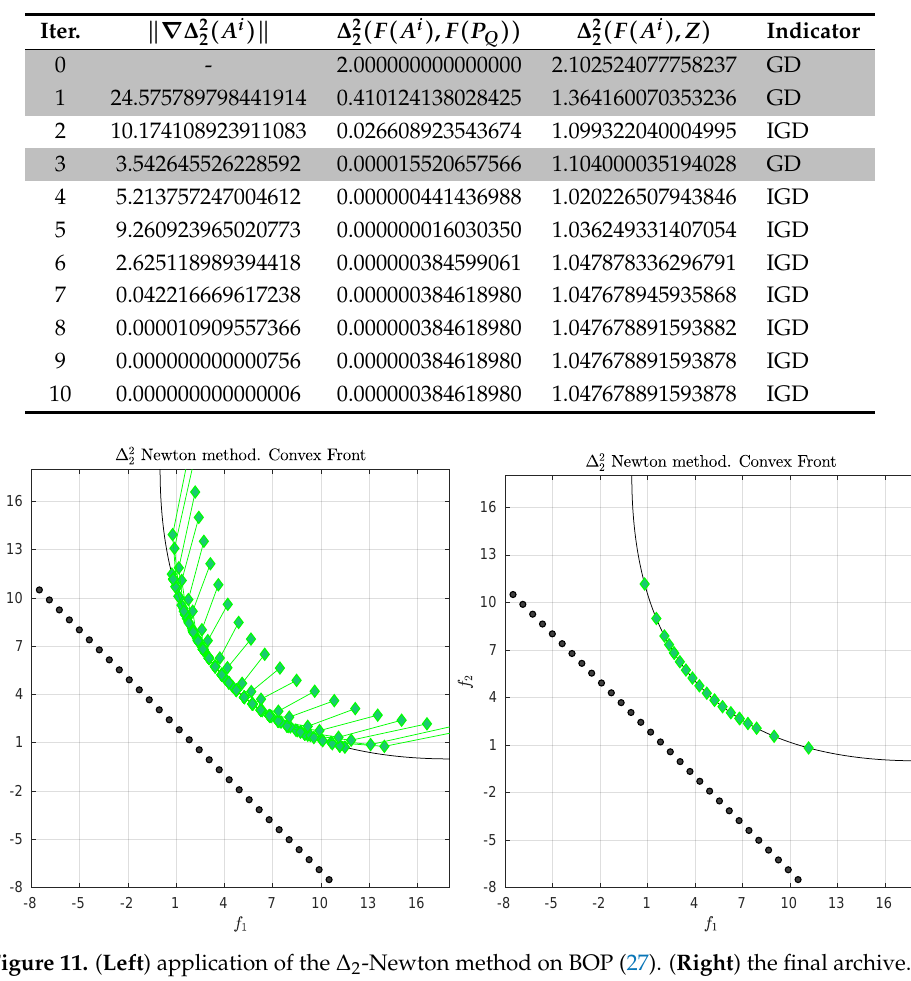
-Newton method on BOP (27), see Figure 11. 2